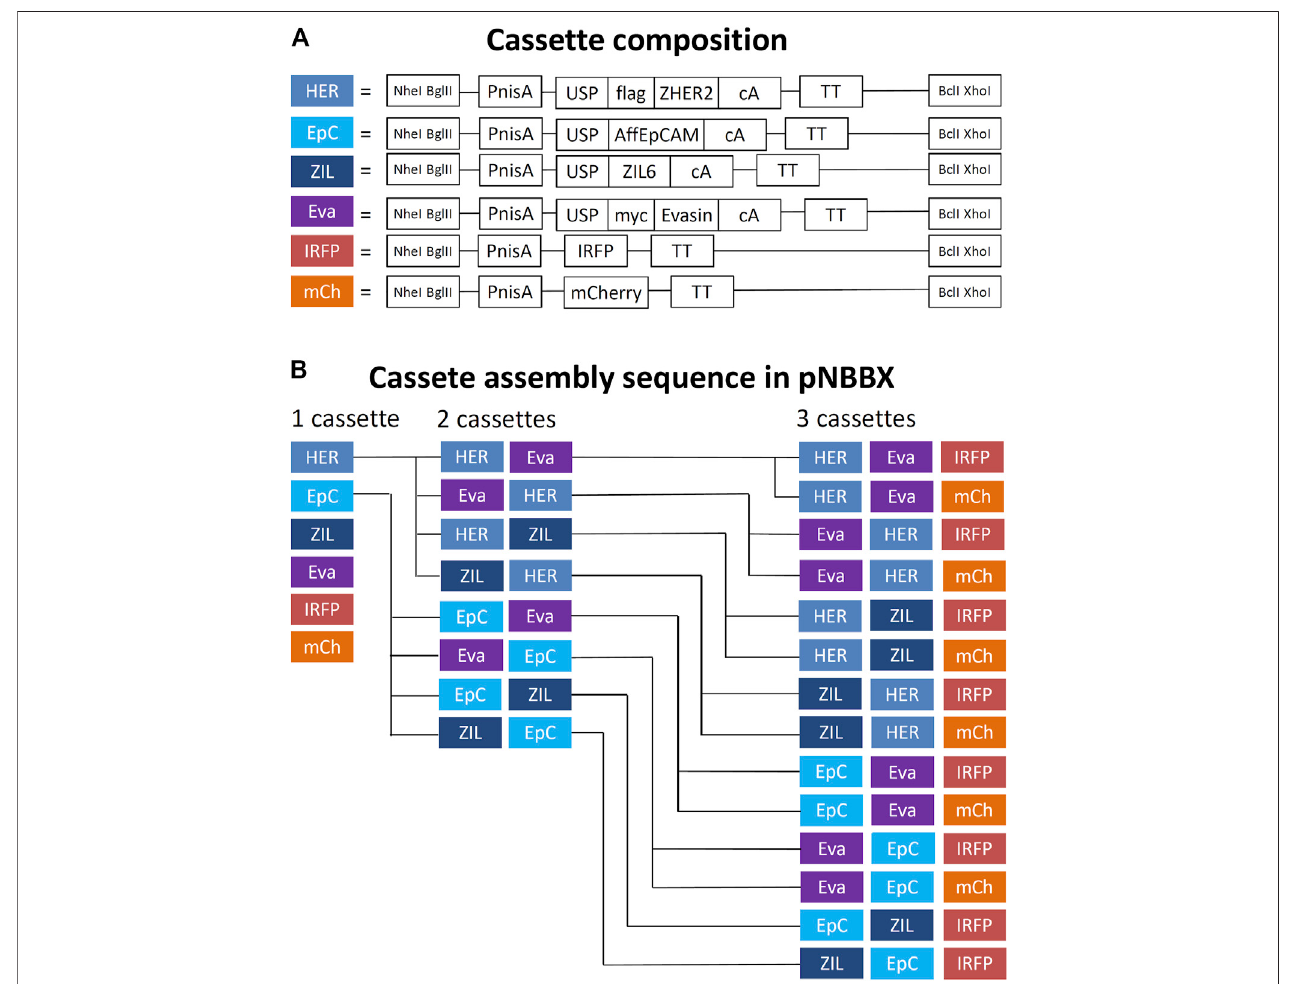
FIGURE2| Schematicrepresentationofcomponentsofgenecassettesformodelrecombinantproteinexpressionandsurfacedisplay (A) andanevolutionarytree of successive assembly of multiple gene cassettes in pNBBX plasmids depicted in 5 ′ to 3 ′ direction (B) . PnisA, nisin promoter; USP, secretion signal; AffEpCAM, EpCAM-targetingaf fi tin;ZHER2,HER2-targetingaf fi body;Evasin,CXCL-8-bindingevasin3;ZIL6,IL-6-bindingaf fi body;IRFP,infrared fl uorescentprotein;mCherry,red fl uorescent protein; cA, cAcmA anchoring domain; fl ag, FLAG-tag; myc, MYC-tag; TT, transcription terminator.